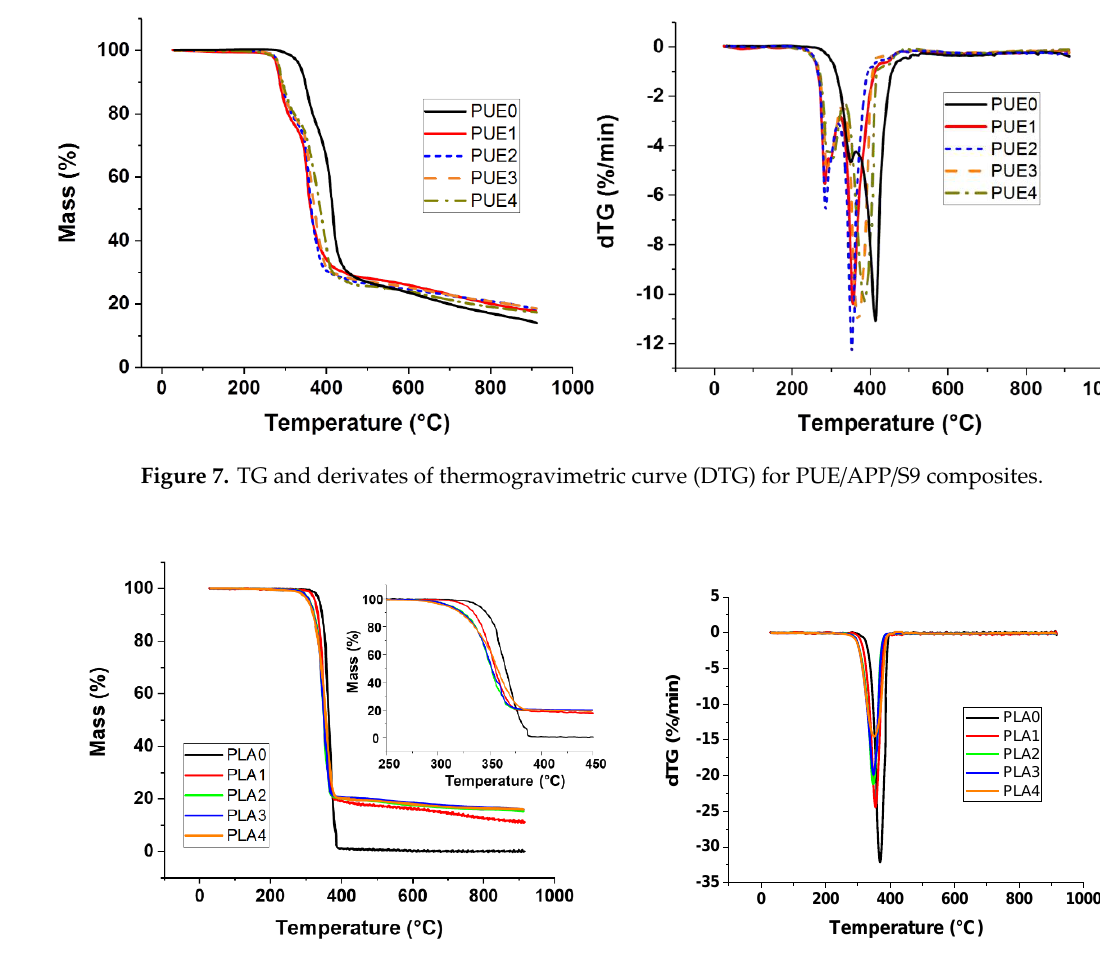
Figure 8. TG and DTG for PLA/APP/S9 composites.